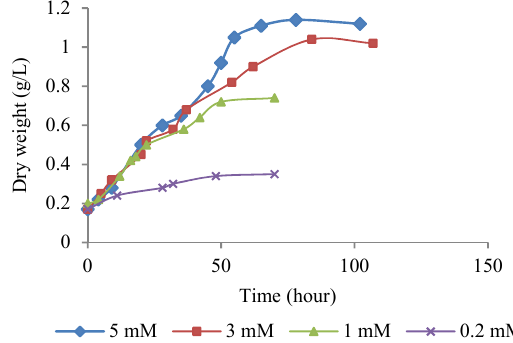
Fig. 2: The effect of different concentrations of potassium nitrate on Chlorella vulgaris biomass (Lv et al ., 2010)